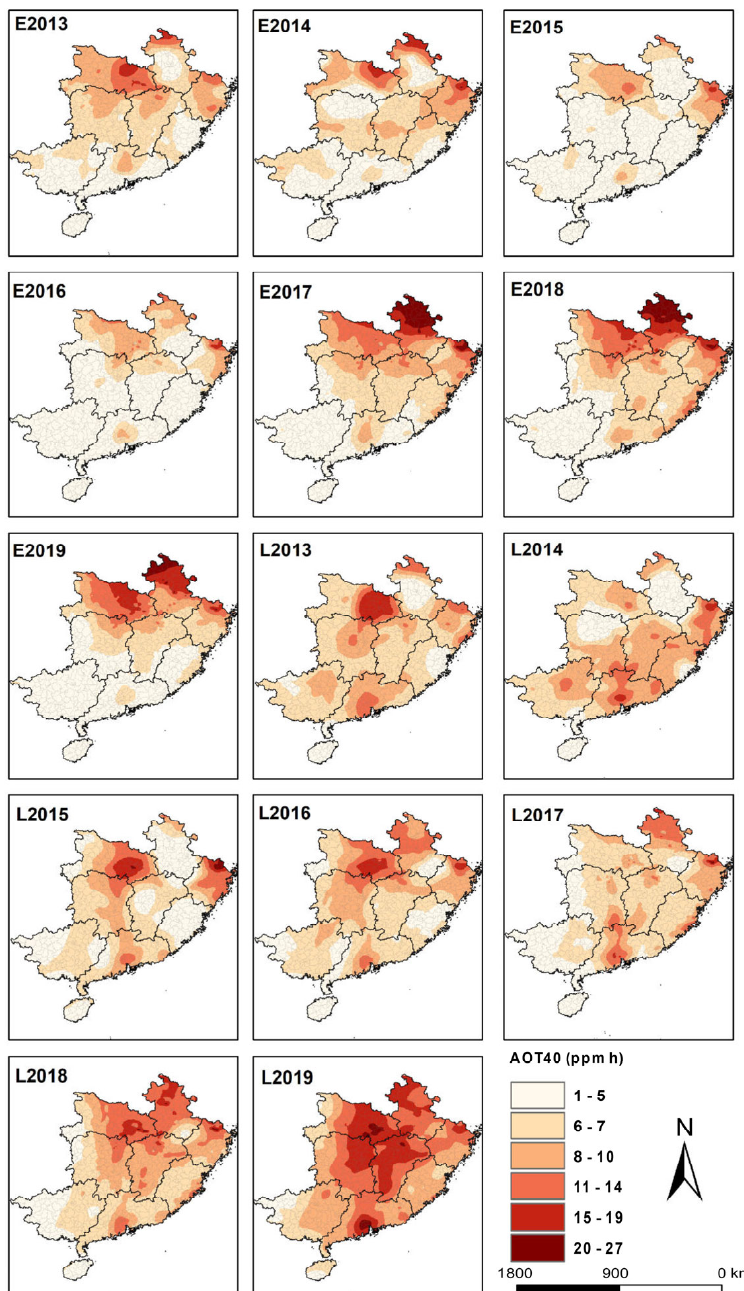
Figure 2. Spatial distribution of AOT40 values over the growing season stages of early rice and late rice from 2013 to 2019. The E and L in the part ‐ labels represent early rice and late rice, respectively.